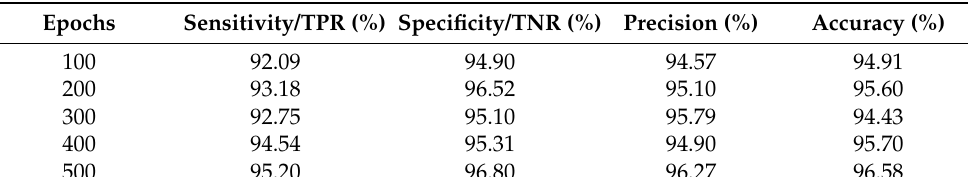
Table 5. The outcome of the proposed Conv-LSTM model.